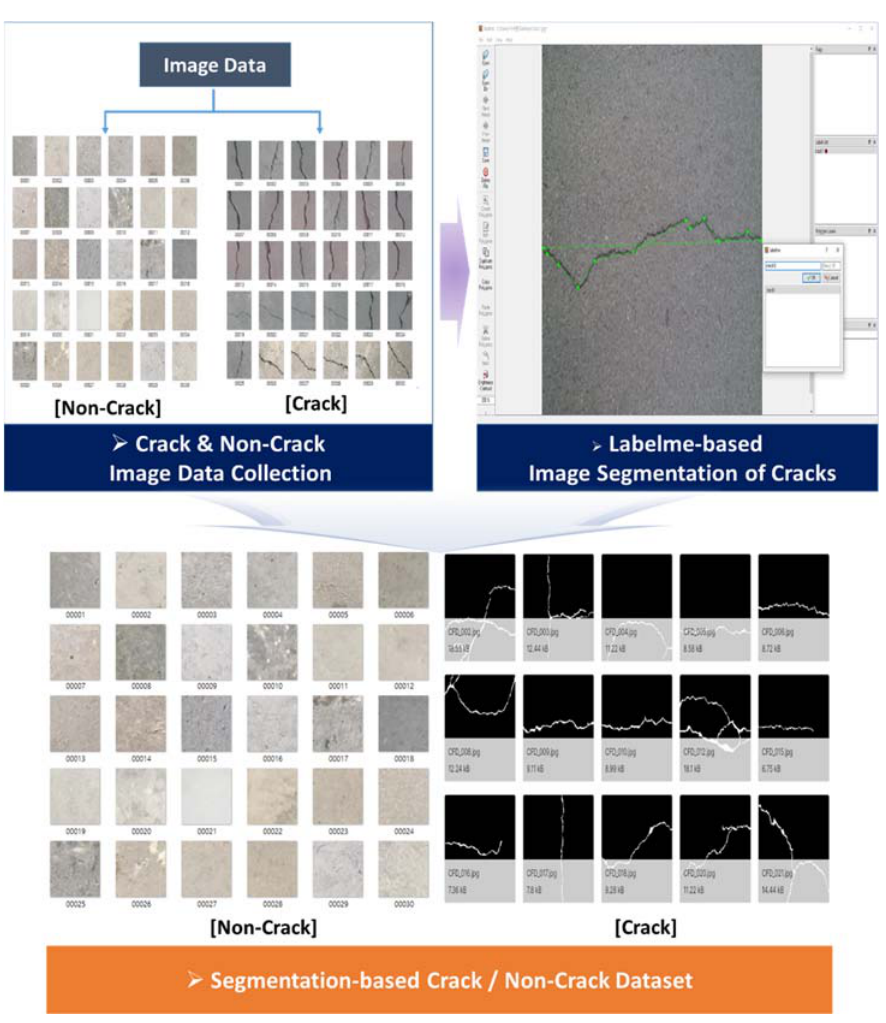
Figure 6. Image Dataset for CNN ‐ based Object Detection Model.